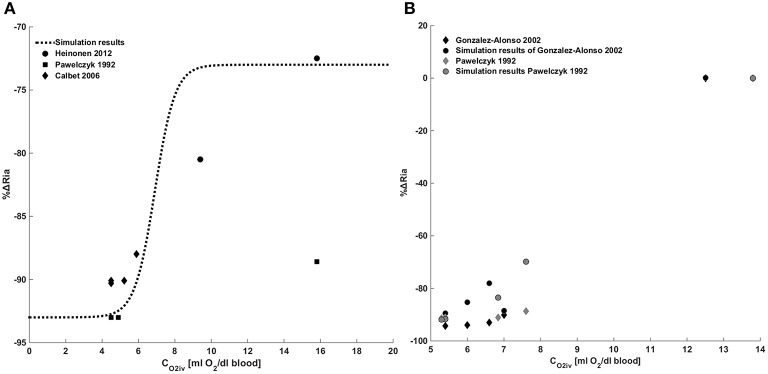
Metabolic control of peripheral resistance. (A) Percentage change of the peripheral resistance due to a change in venous oxygen concentration during exercise in the absence of a sympathetic control. Comparison between simulations output and the data from Pawelczyk et al. (1992) and Gonzalez-Alonso et al. (2002). (B) Percentage change of the peripheral resistance due to a change in venous oxygen concentration during exercise in presence of sympathetic control. Comparison between simulations output and the data from Pawelczyk et al. (1992), Calbet (2006) and Heinonen et al. (2013).